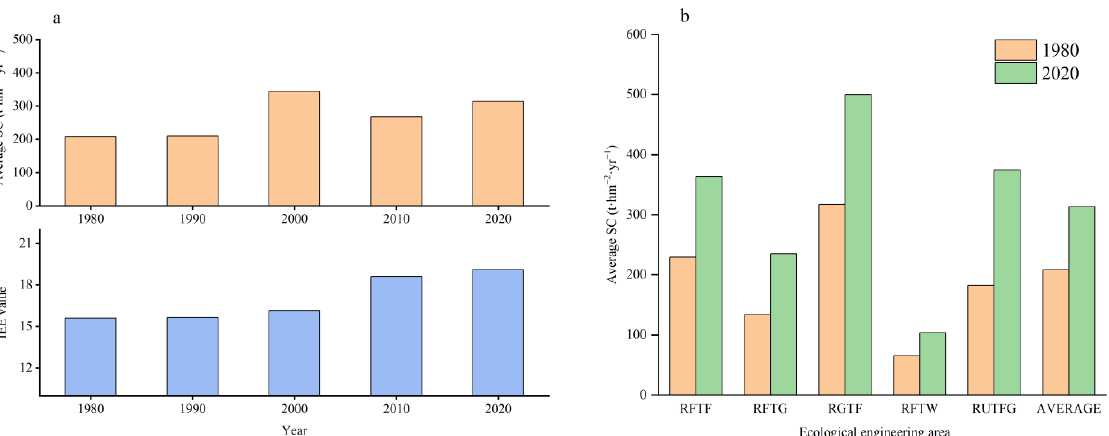
Figure 6. Spatial distribution of SCSs in the Taihang Mountain area from 1980 to 2020.